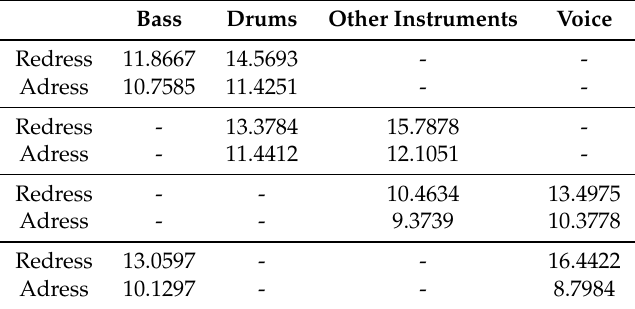
Table 1. Av. SNR (dB) of the source estimates: 2-source mixtures.